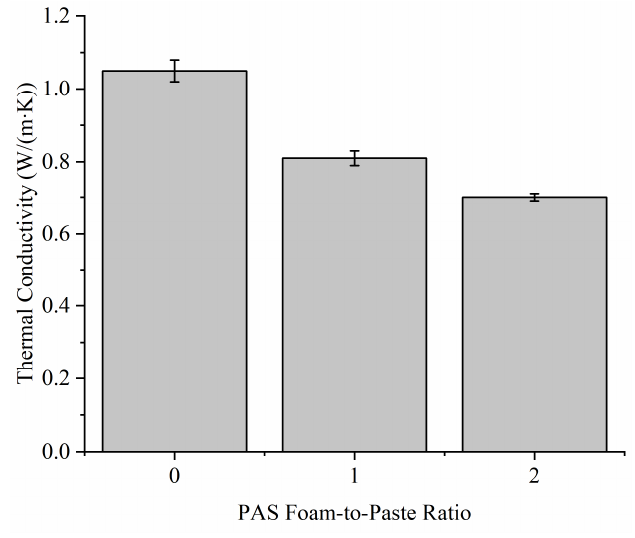
Figure 5. Thermal conductivity of G-0, G-1 and G-2.